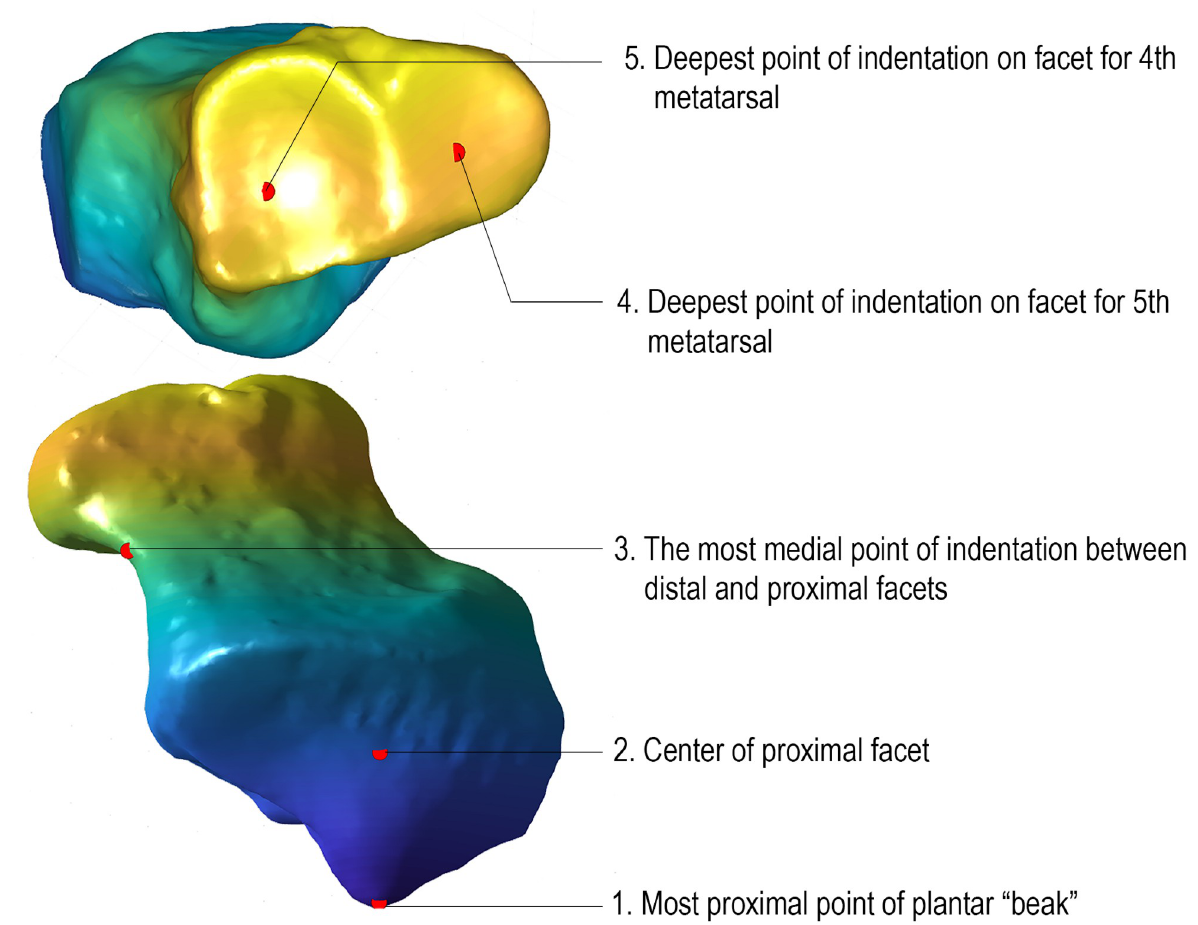
Fig 10. Hylobates Cuboid showing validation landmarks. Red dots indicate where landmarks are manually placed on 69 sample cuboid meshes.